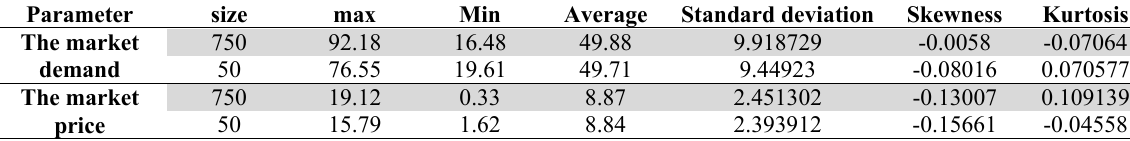
Descriptive statistics of the original and the new set of scenarios